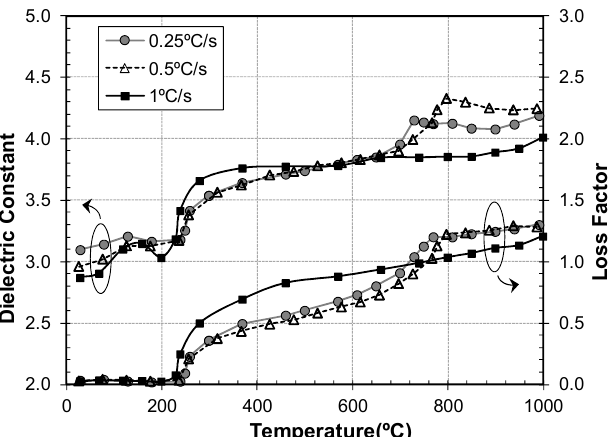
Figure 5. Dielectric properties of zirconia samples at microwave frequencies during the heating process at different heating rates (0.25 °C/s, 0.5 °C/s and 1 °C/s).